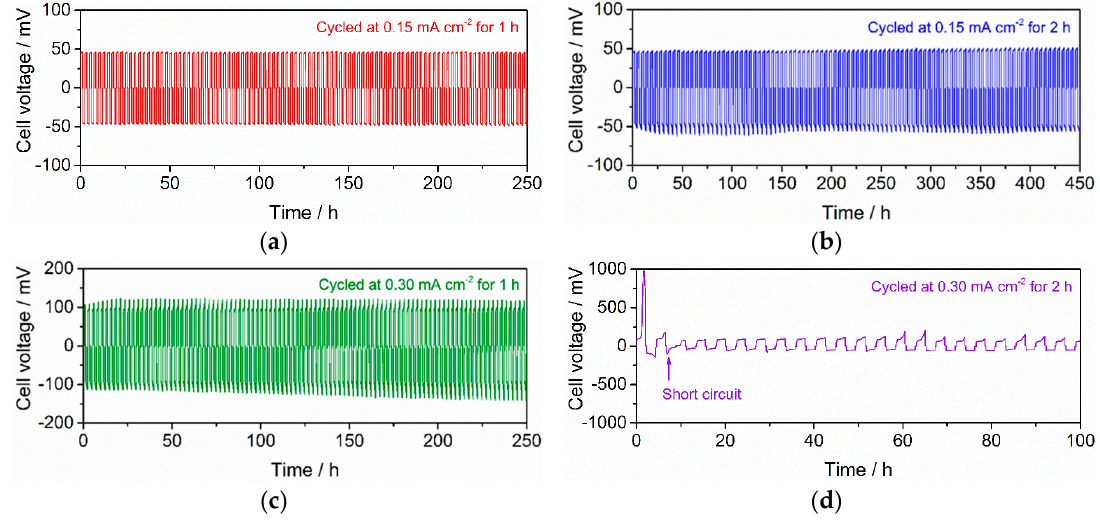
Figure 8. Galvanostatic cycling at 25 °C for Li/LLZT/Li cell with R Li-LLZT (27 °C) = 25 Ω cm 2 : ( a ) cycled at 0.15 mA cm − 2 for one hour, ( b ) cycled at 0.15 mA cm − 2 for two hours, ( c ) cycled at 0.30 mA cm − 2 for one hour, and ( d ) cycled at 0.30 mA cm − 2 for two hours. The measurements were continuously recorded from ( a ) to ( d ).